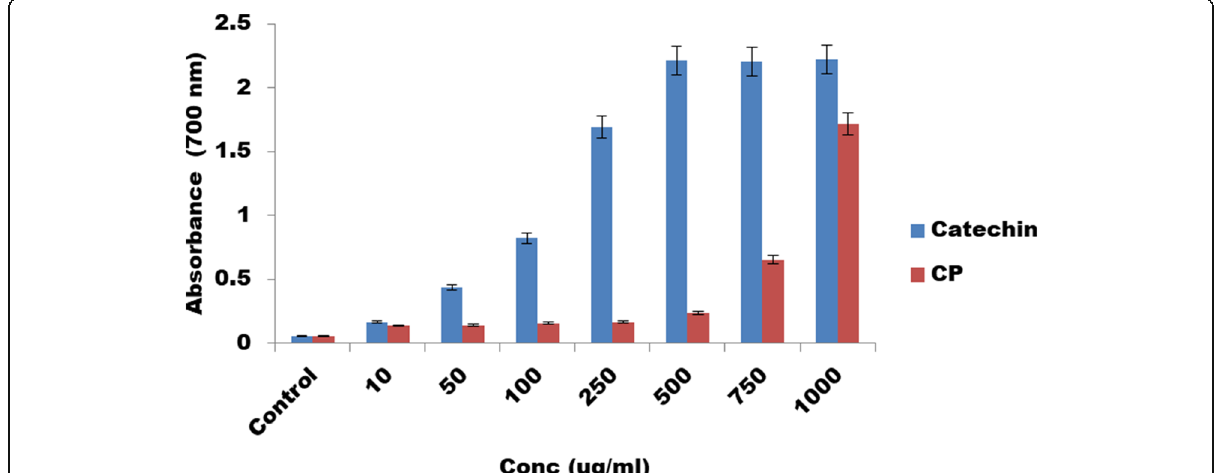
Fig. 6 Reducing power assay of Calotropis procera leaf. It revealed that at 1000 ug/ml, the reducing power was similar to the standard catechin. Data are expressed as mean ± SD ( n =